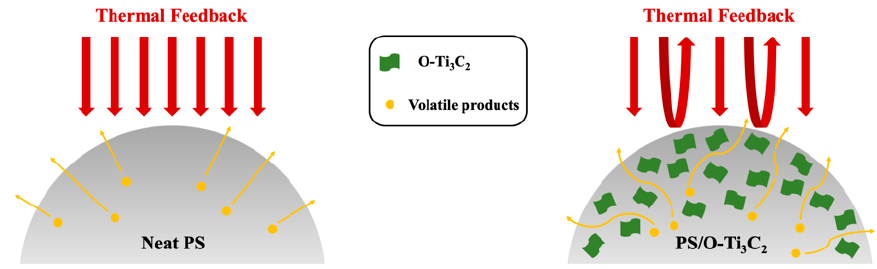
Figure 6. Proposed mechanisms of reduced flammability of PS/O-Ti 3 C 2 nanocomposites.